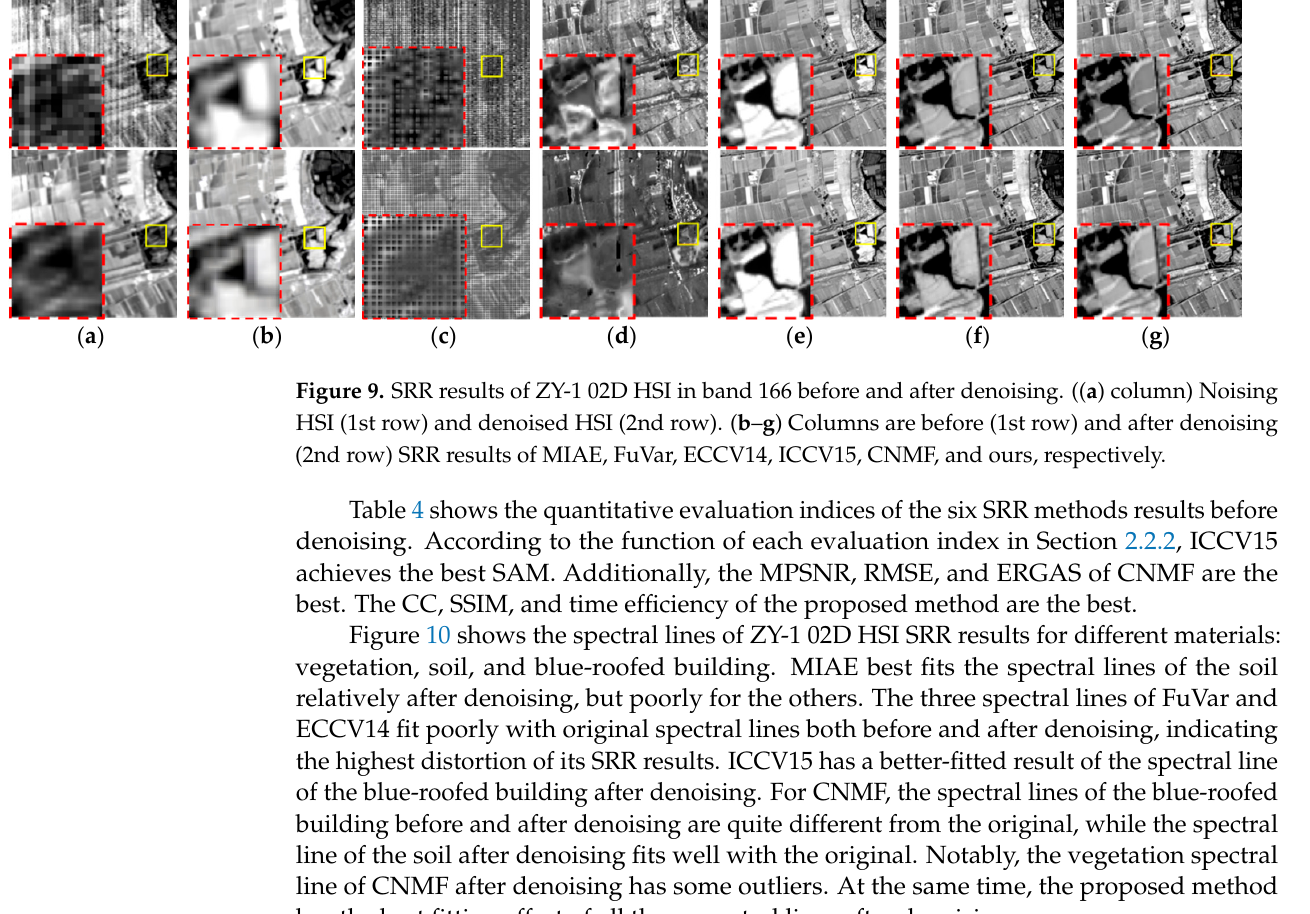
Figure 8. The SRR results before and after denoising in ZY-1 02D HSI. (( a ) column) Noised HSI (1st row), MSI (2nd row). ( b – g ) Columns are SRR results before denoising (1st rows) and after denoising (2nd rows) of MIAE, FuVar, ECCV14, ICCV15, CNMF, and the proposed method.